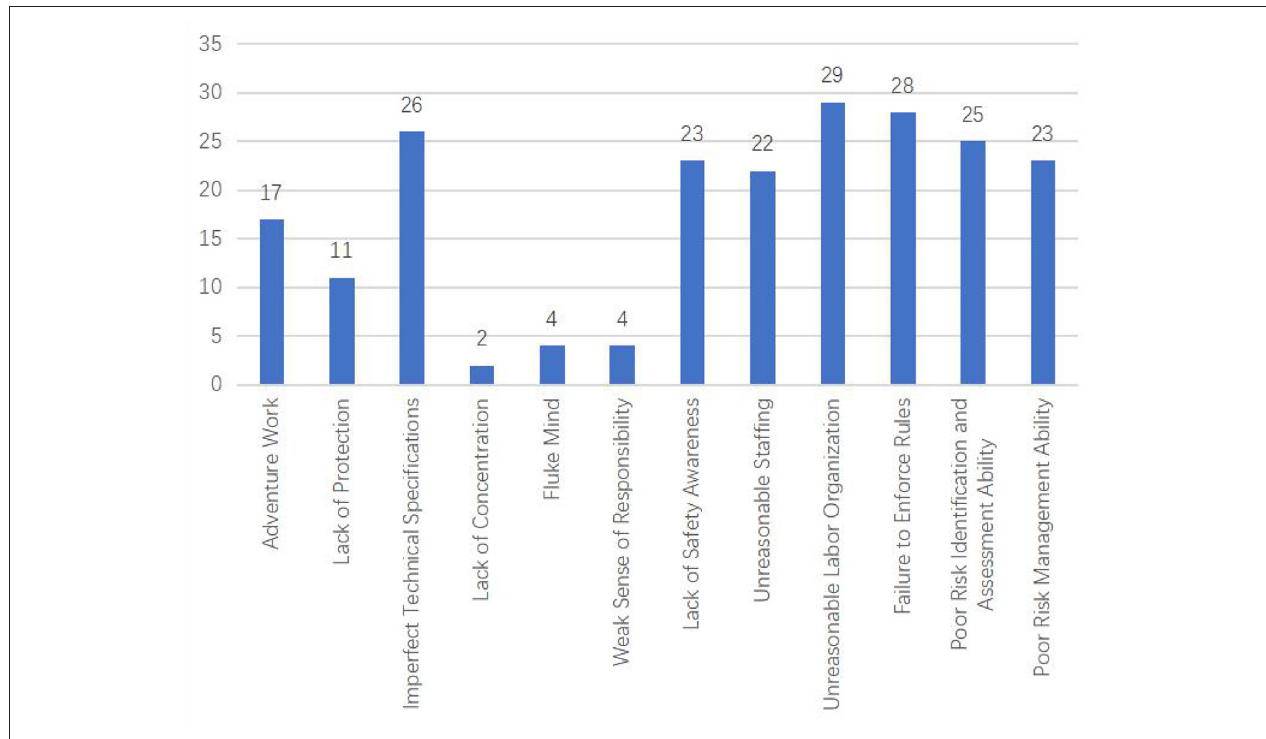
FIGURE 7 | Statistics of miners’ unsafe acts